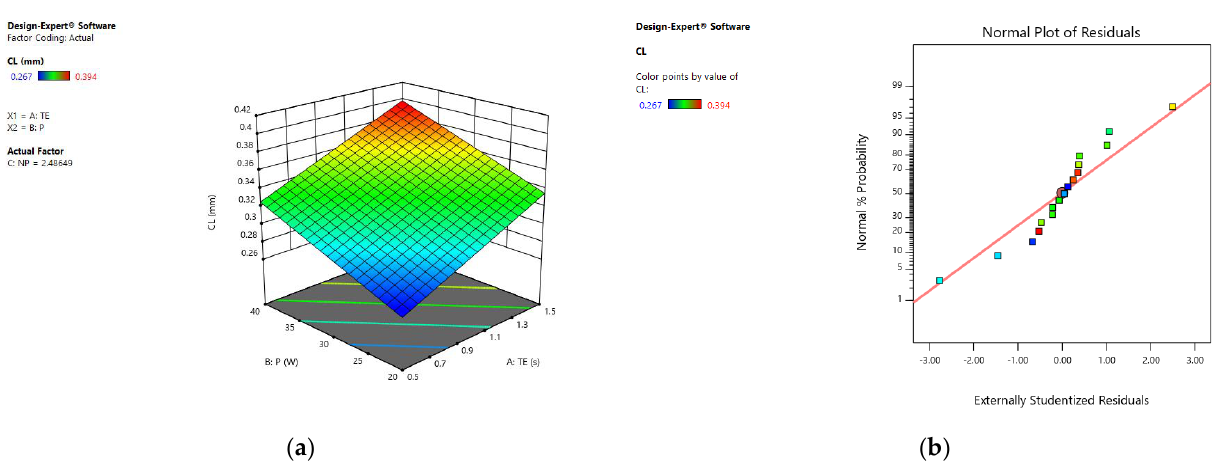
Figure 16. ANOVA model results for CL at 0.05 wt.% CNPs: ( a ) 3D response surface and ( b ) normal residuals plot.